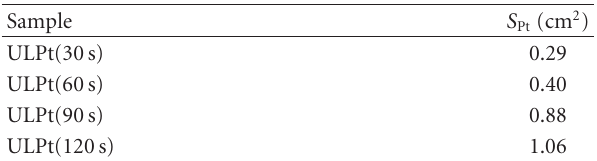
Table 2: Pt active area ( S Pt ) corresponding to the deposition time calculating by using CVs in 0.5 M sulfuric acid solution as shown in Figure